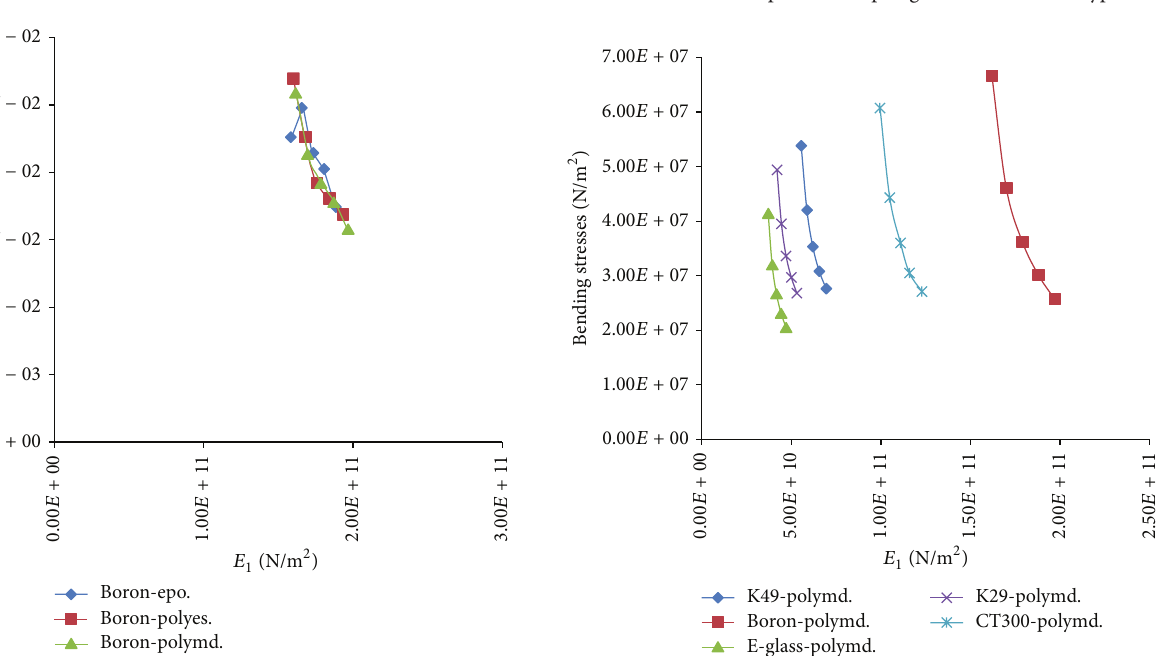
Figure 18: Effect of longitudinal modulus of elasticity on bending stresses of various composite leaf springs based on matrix type.